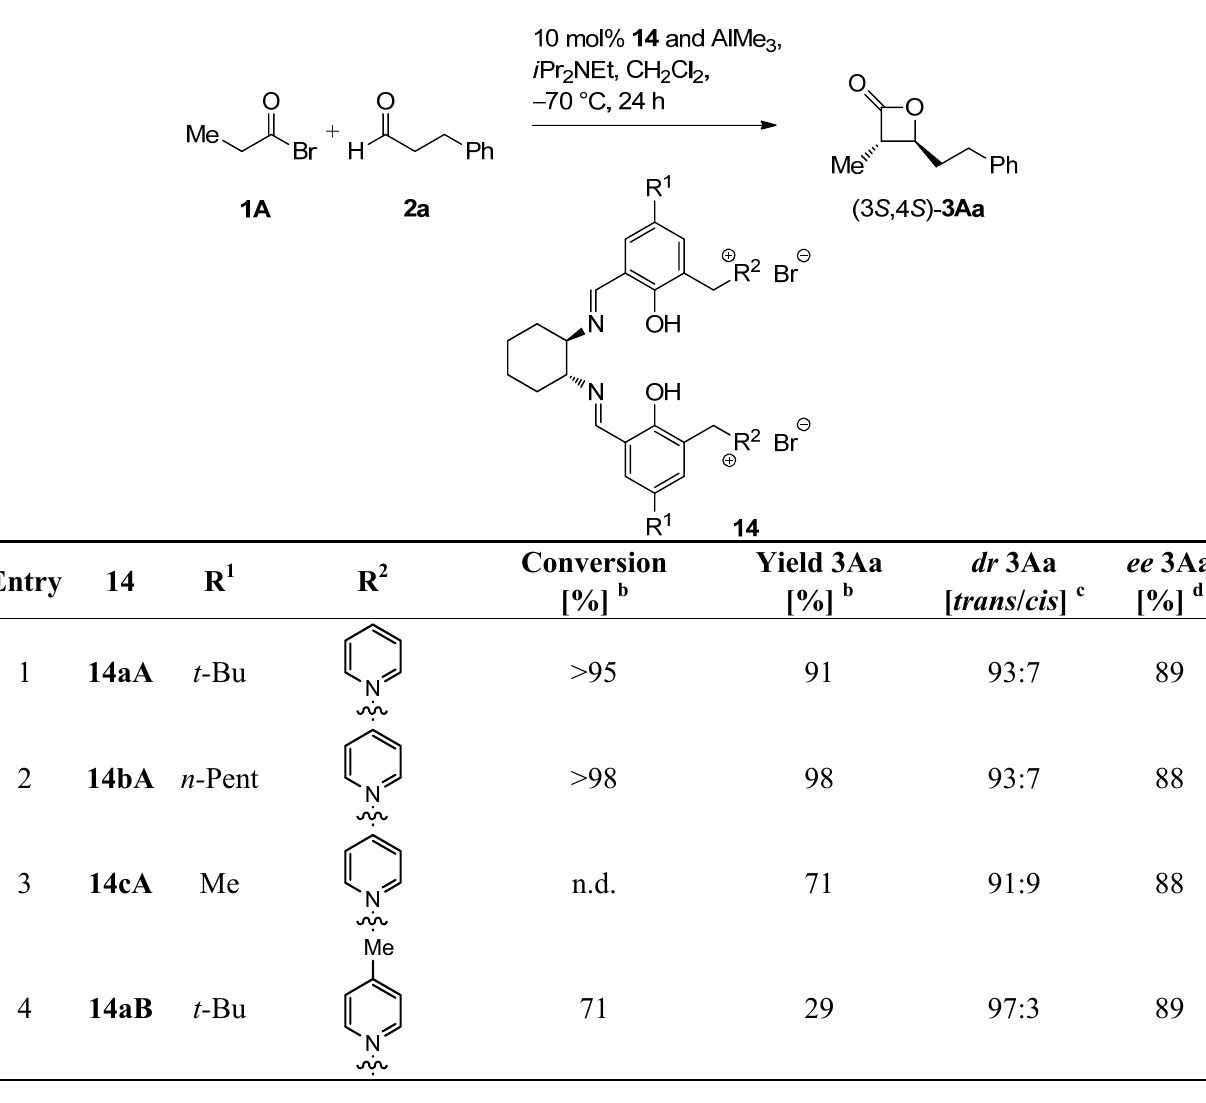
Table 2. Investigation of salen ligands 14 carrying different pyridinium moieties R 2 in